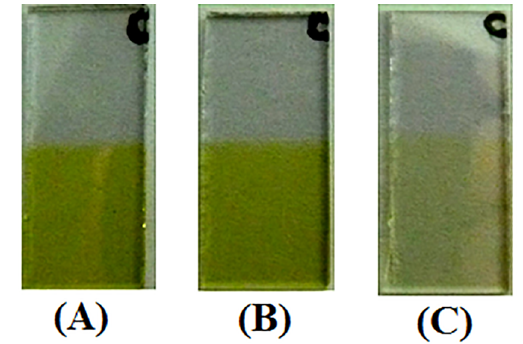
Figure 2. Samples images of the films studied with different thicknesses after heat Figure 3. 29 Table 1 shows the thickness and surface density against the mass of the evaporating V O powder. 2 5 The CaKα comes from borosilicate substrate, and the values were shown in Table 1. The samples morphology were analyzed by atomic force microscopy (AFM), (Nanosurf), in the intermittent contact mode. Images were acquired covering 30 x 30 µm 2 with 512 points per line. The RMS (root mean square) was obtained by Gwyddion software. The X-ray diffraction (XRD) measurements were performed on a Bruker D8 diffractometer with CuKα radiation, θ-2θ geometry, angle range from 18 to 25º (2θ), the step size of 0.05 º and 5 s for counting time per point. The X-ray tube voltage and current were 40 kV and 40 mA, respectively. The crystallite size (S) was calculated from the (001) peak of the samples, using Scherrer equation: